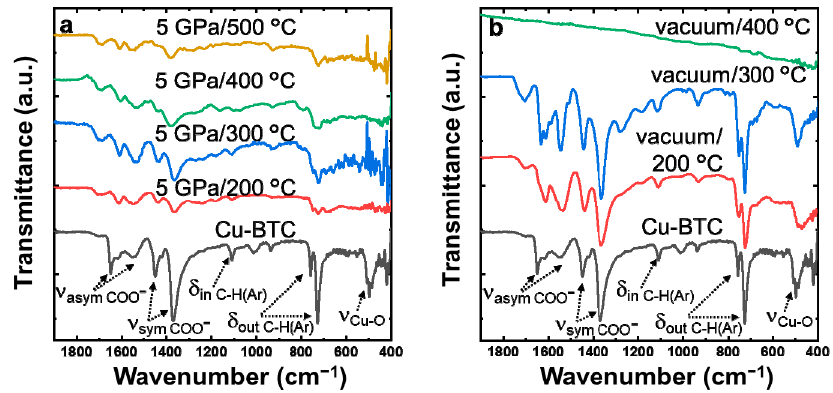
Figure 2. FTIR spectra of ( a ) the HPHT samples and ( b ) the samples pyrolyzed in the vacuum-sealed glass tubes. Marks of IR peaks ν , δ , and Ar in the figures denote stretching, bending, and the benzene ring, respectively.